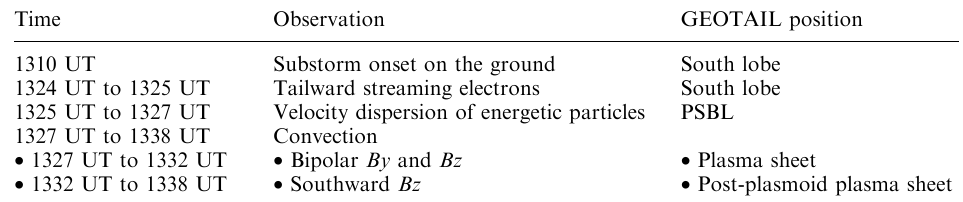
Table 4. The sequence of events as determined from the analysis of GEOTAIL data for the flux rope signature centred at 1331 UT on March 31,